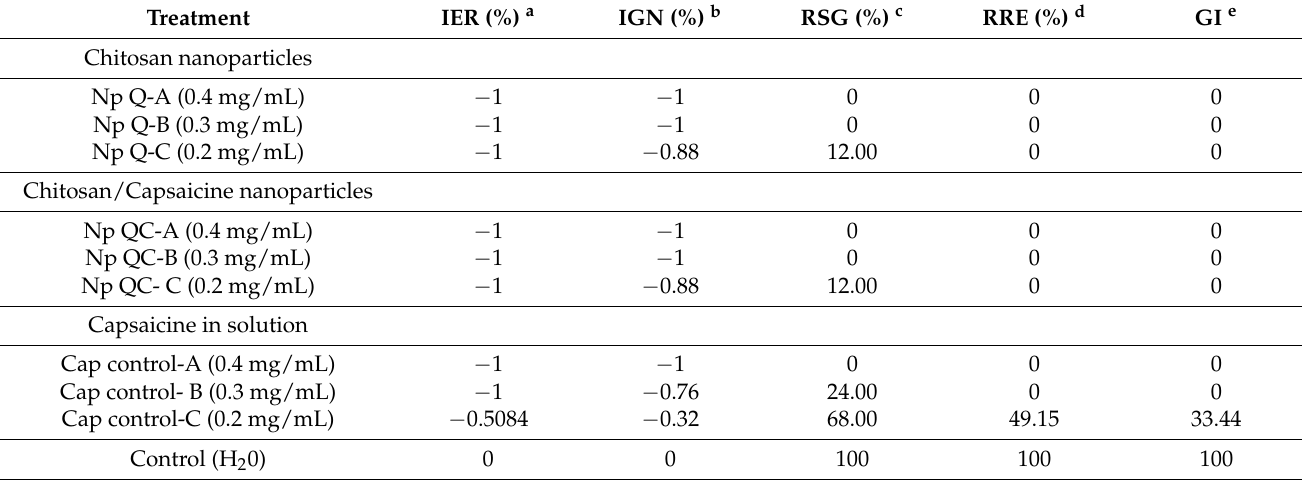
Table 3. Inhibition of seed germination and elongation of radicle and hypocotyl of L. sativa seeds exposed to Np Q and Np QC treatments, and capsaicin in solution for 120 h of storage at 24 ± 0.1 ◦